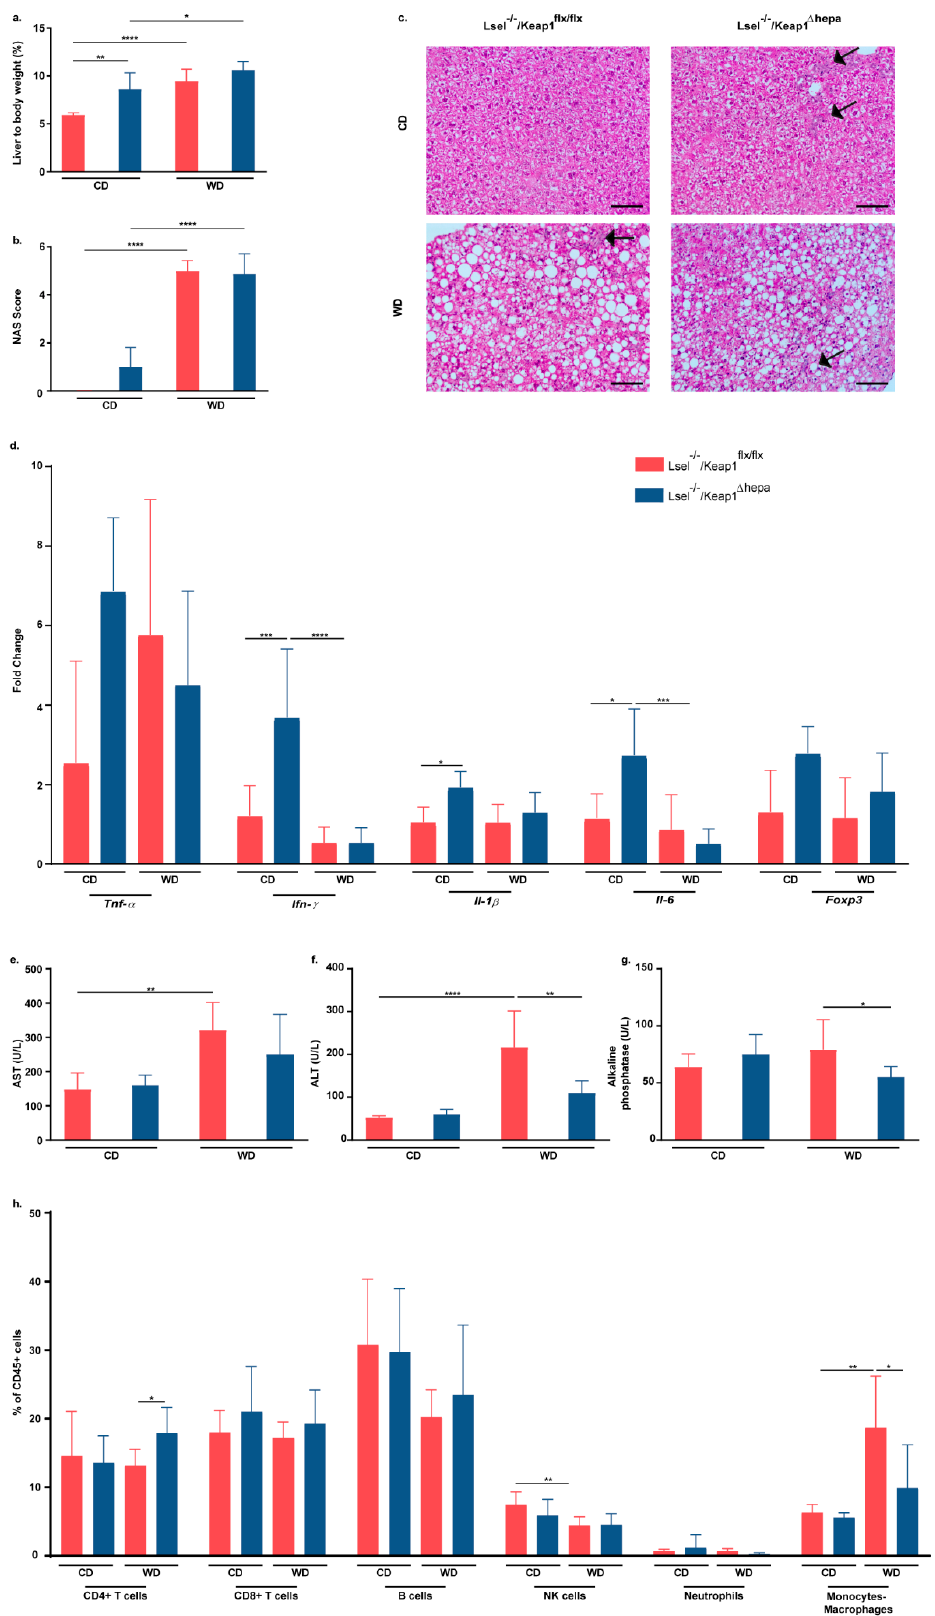
Figure 3. Lsel − / − Keap1 ∆ hepa mice are not additionally protected from WD-induced NASH progres- sion. Lsel − / − Keap1 flx/flx mice (shown in red) and Lsel − / − Keap1 ∆ hepa mice (shown in blue)